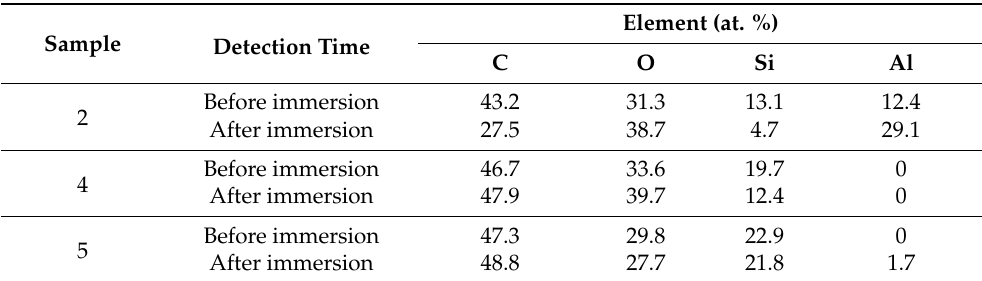
Table 2. Elemental composition of samples 2 and 5 as measured by XPS before and after their immersion in water for 120